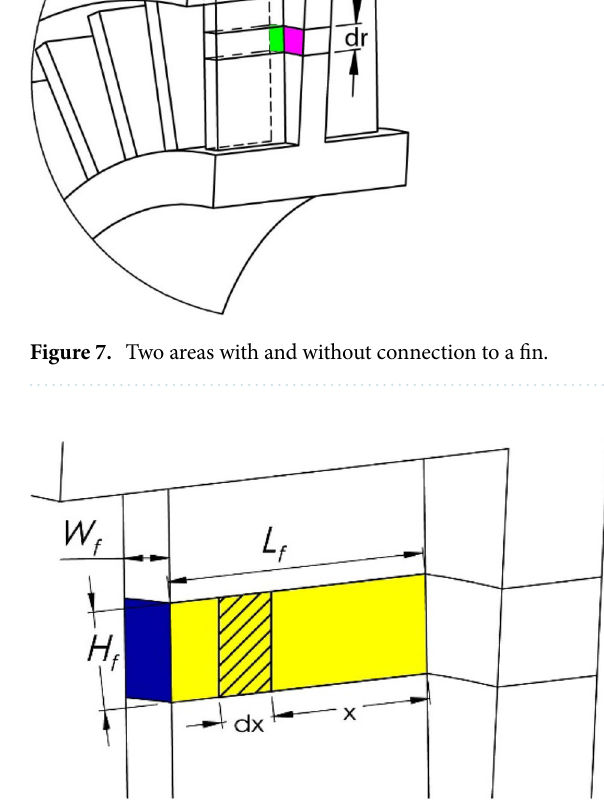
Figure 8. Geometry of the